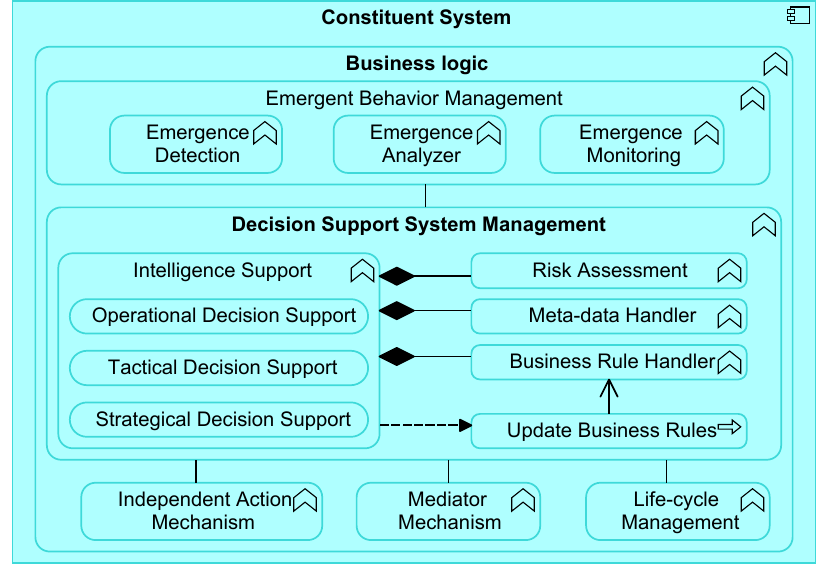
Figure 4. Architectural view on the business logic